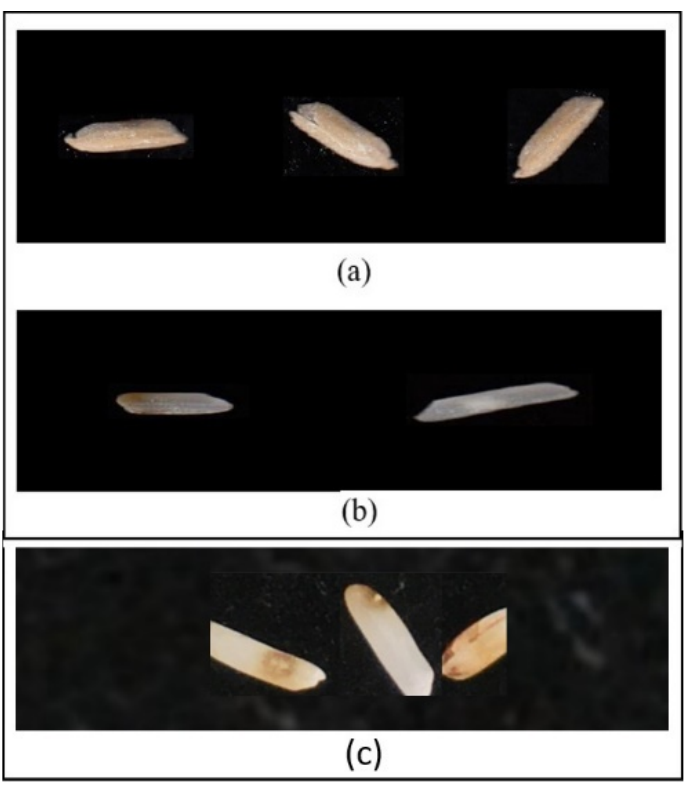
11 of 18 Figure 9. Process diagram of the transfer learning model VGG19. 5.6. Broken Rice